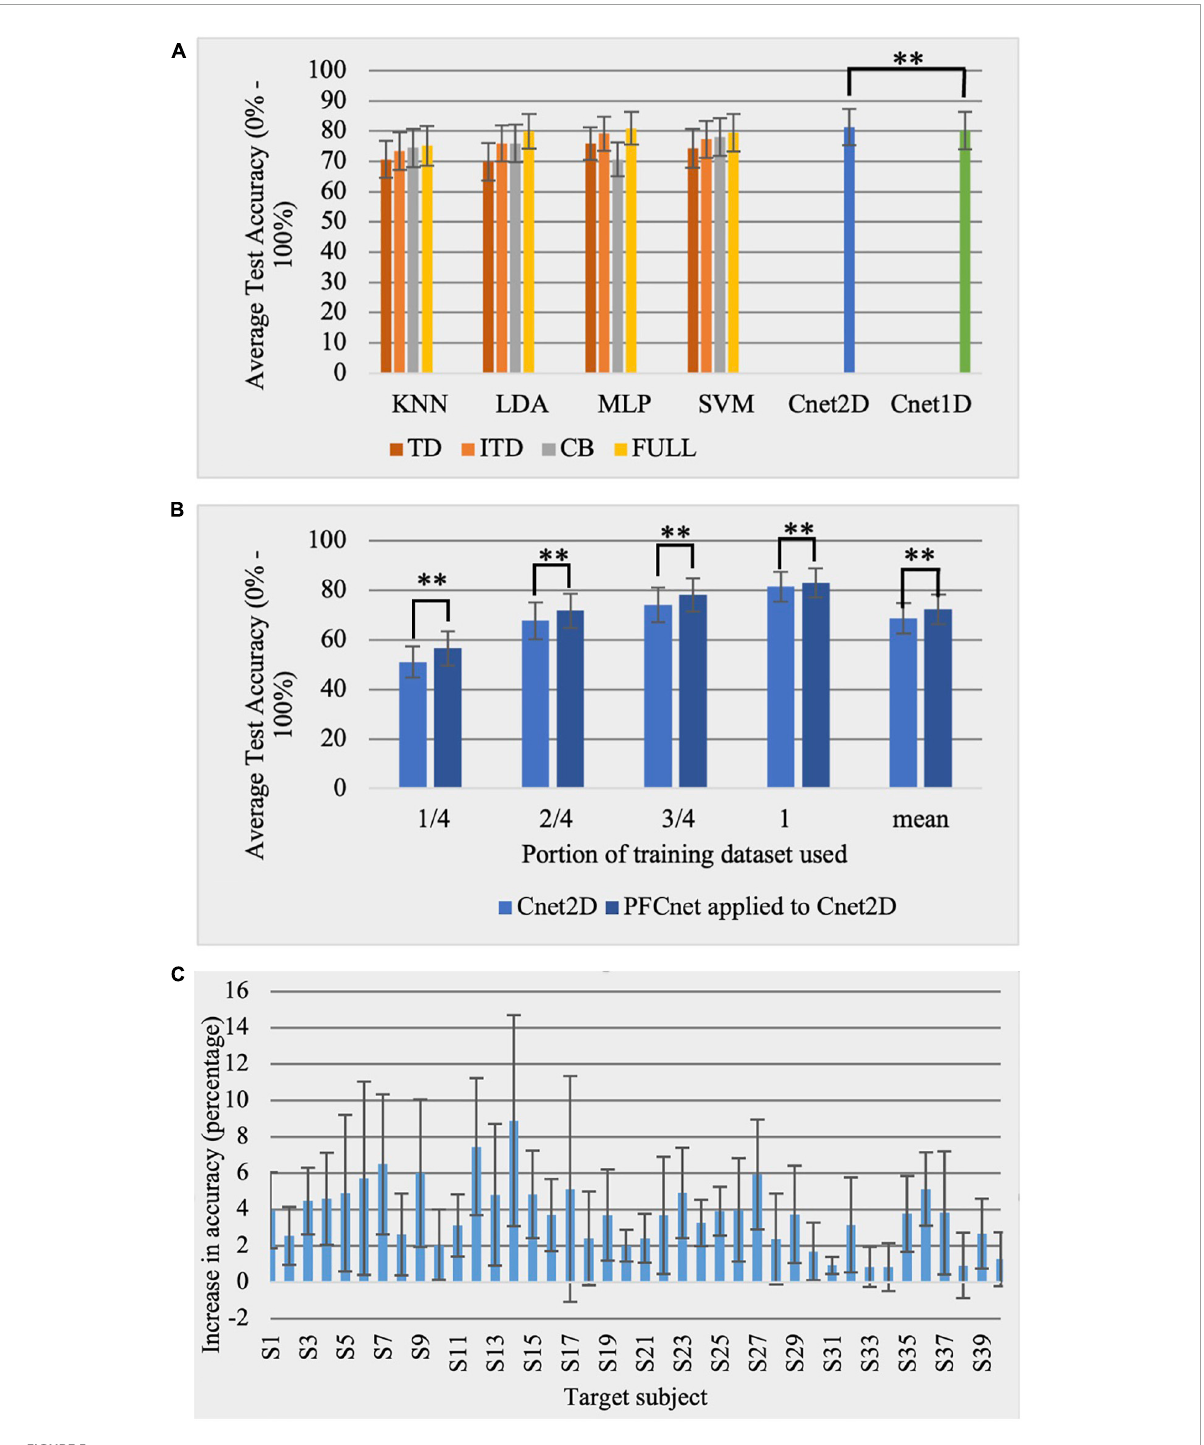
FIGURE5 Ninapro dataset results with 17 classes (chance accuracy level = 5.88%). (A) Comparison between reference classical classifiers with 4 features sets and the proposed deep networks for Ninapro DB2 database. (B) Effect of subject-transfer (PFCnet applied to Cnet2D) for Ninapro DB2 database when training with a limited amount of data (**Corresponds to p < 0.01). (C) Accuracy improvement when subject-transfer learning is applied to Cnet2D for each Ninapro DB2